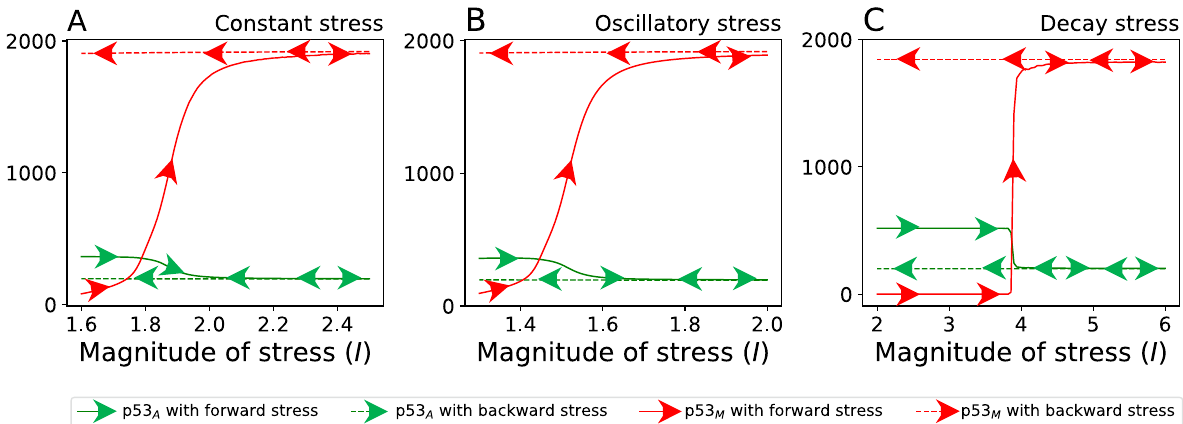
Figure 5. Hysteresis plot for three different type of stress as discussed in main text. ( A ) Increasing the magnitude of stress, apoptotic state moves towards cancer phase while decreasing stress, the cancer phase does not come back to apototic phase. ( B ) and ( C ) show similar pattern for oscillatory and decaying stress respectively. Solid and dashed arrow correspond to increasing and decreasing stress magnitude respectively. For solid arrow the initial value of variable corresponds to apoptotic phase while dashed arrow correspond to cancer phase. Parameters used in the figure correspond to the parameters used in Fig. 4 B 2 , C 2 , and C 2